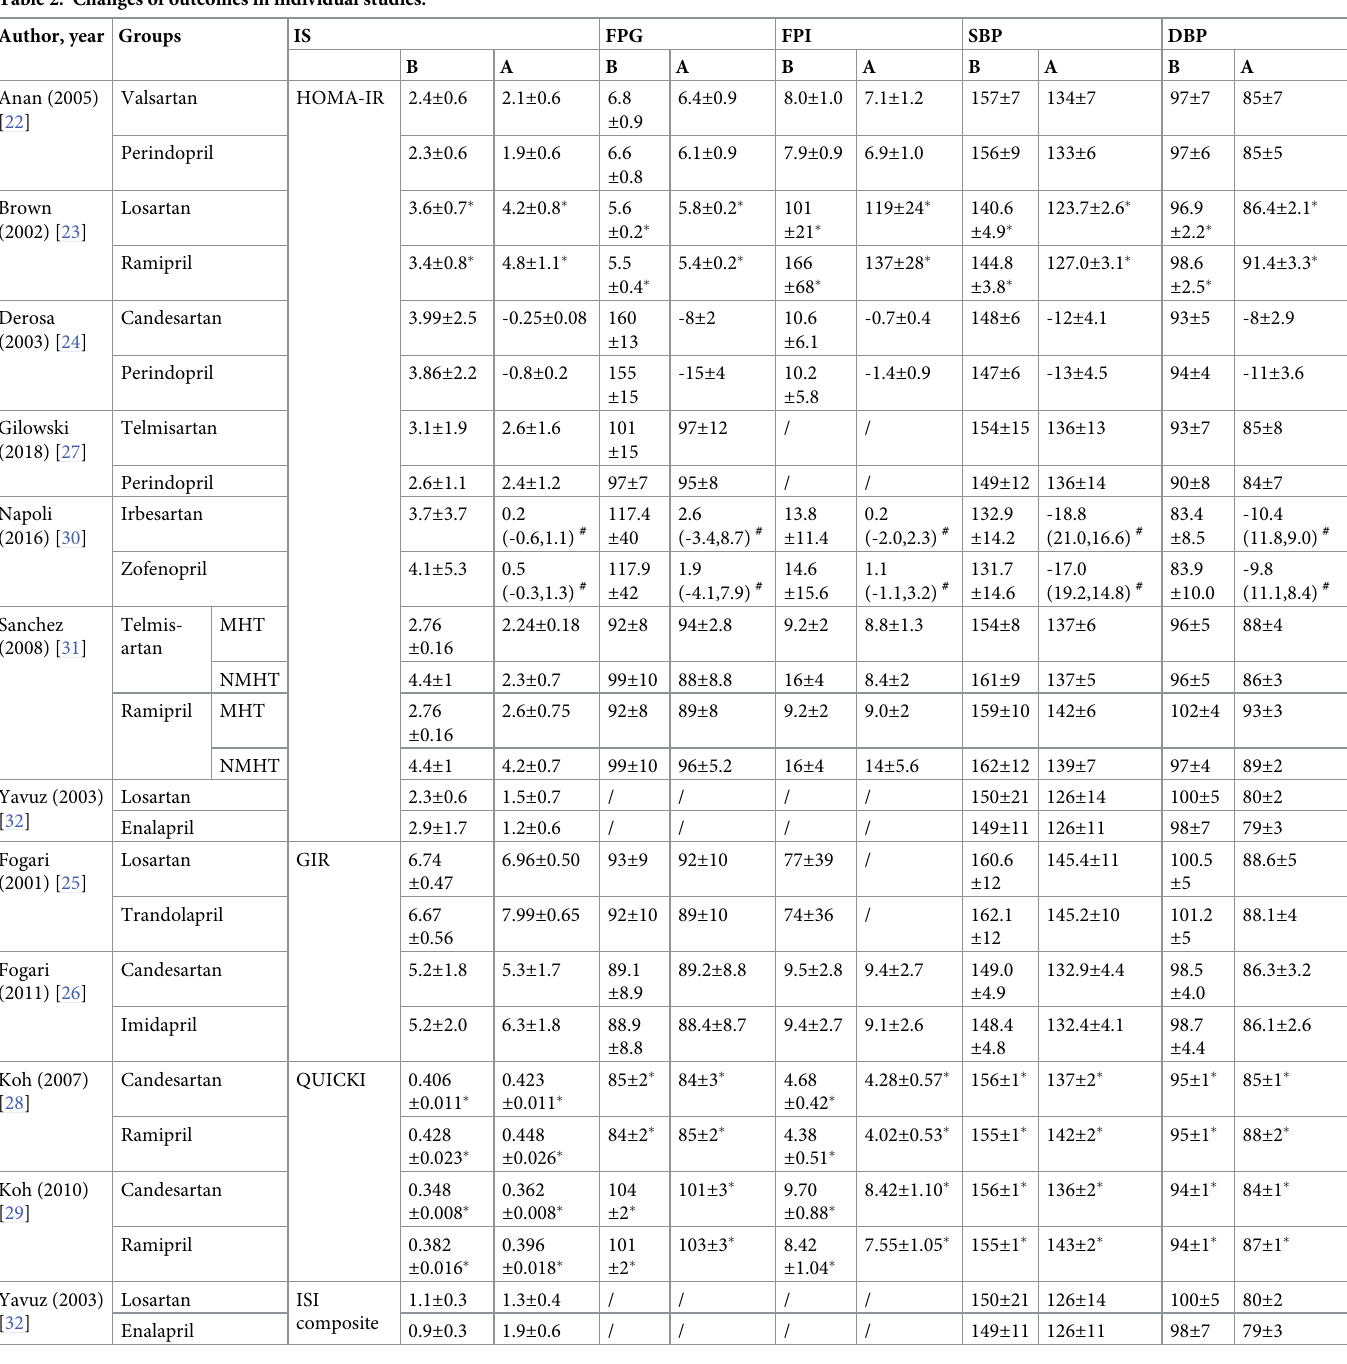
Table 2. Changes of outcomes in individual